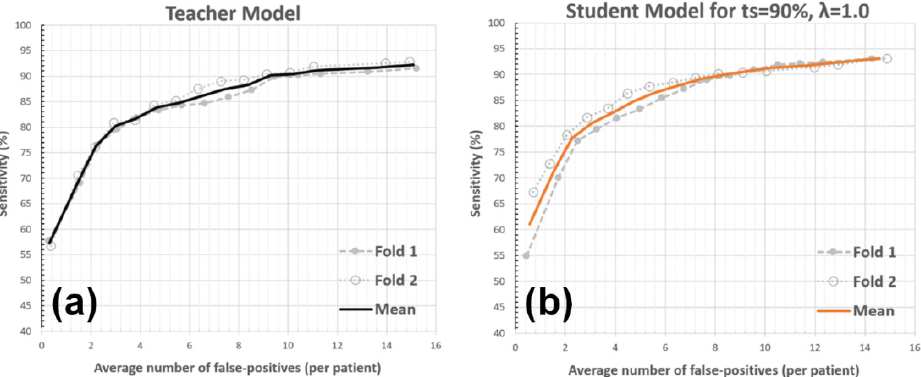
Figure 5. AFP versus detection sensitivity. The average number of false positives per patient (i.e., wrongly detected BM lesions for each patient) in relation to the sensitivity is illustrated for the teacher ( a ) and student ( b ) models. The mean curve (shown as the thick-line curve) represents the average of the CV folds.